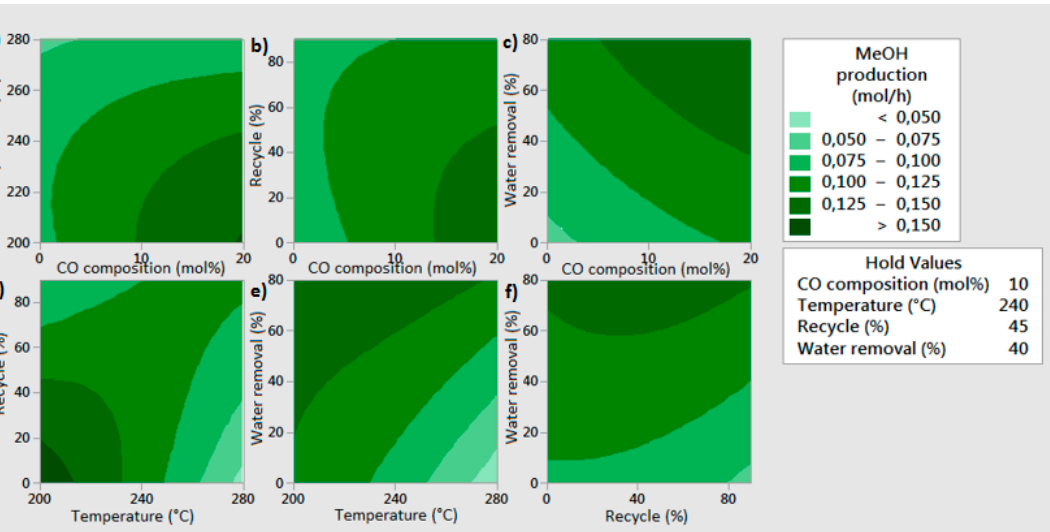
Figure 10. Surface plots of methanol production obtained by CCD analysis: ( a ) methanol production as function of temperature and CO composition in the feed; ( b ) methanol production as function of recycle and CO composition in the feed; ( c ) methanol production as function of water removal and CO composition in the feed; ( d ) methanol production as function of recycle and temperature; ( e ) methanol production as function of water removal and temperature; ( f ) methanol production as function of water removal and recycle.